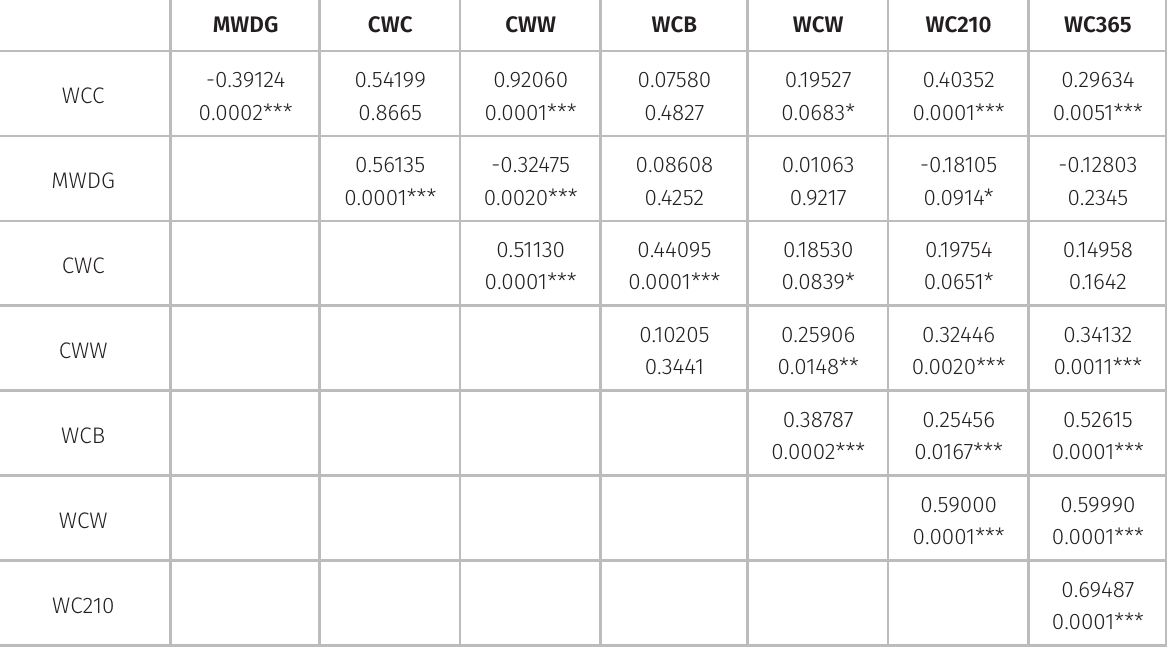
Table III. Pearson correlations for the developmental variables of cows and their calves for different primiparous conception weights and different weight gains during the second